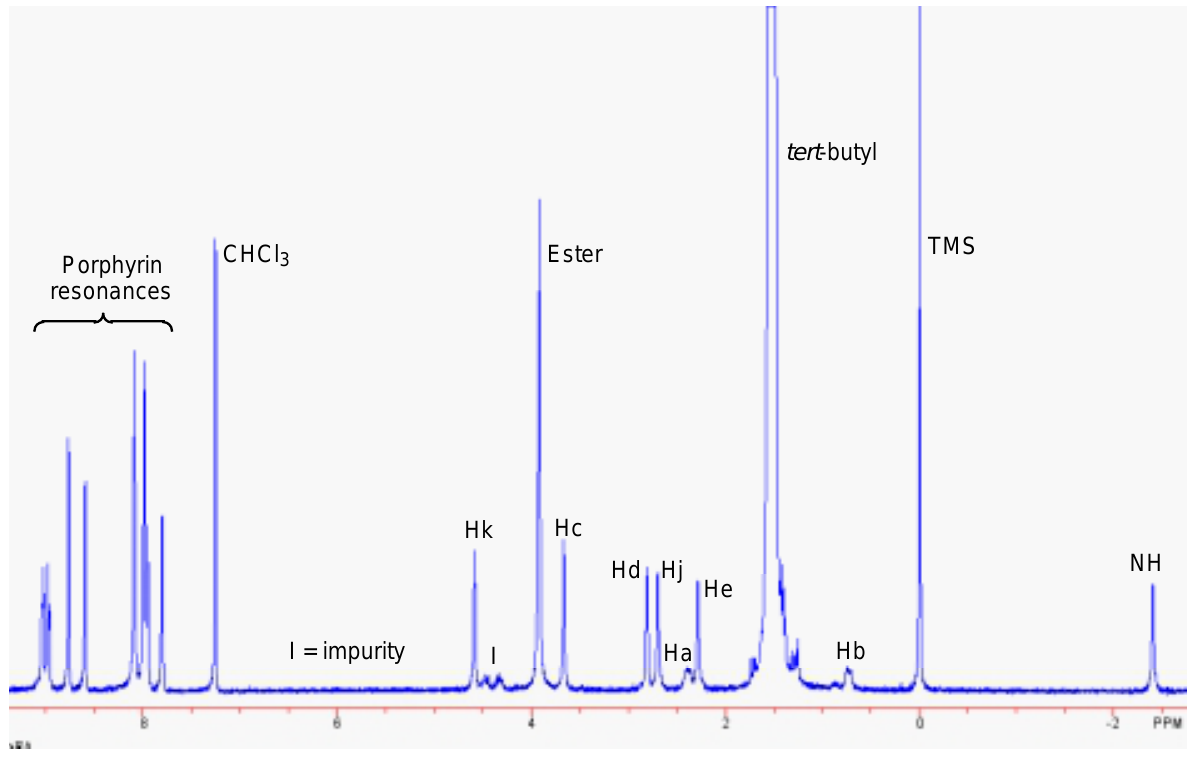
) of bis -porphyrin cavity 10 3